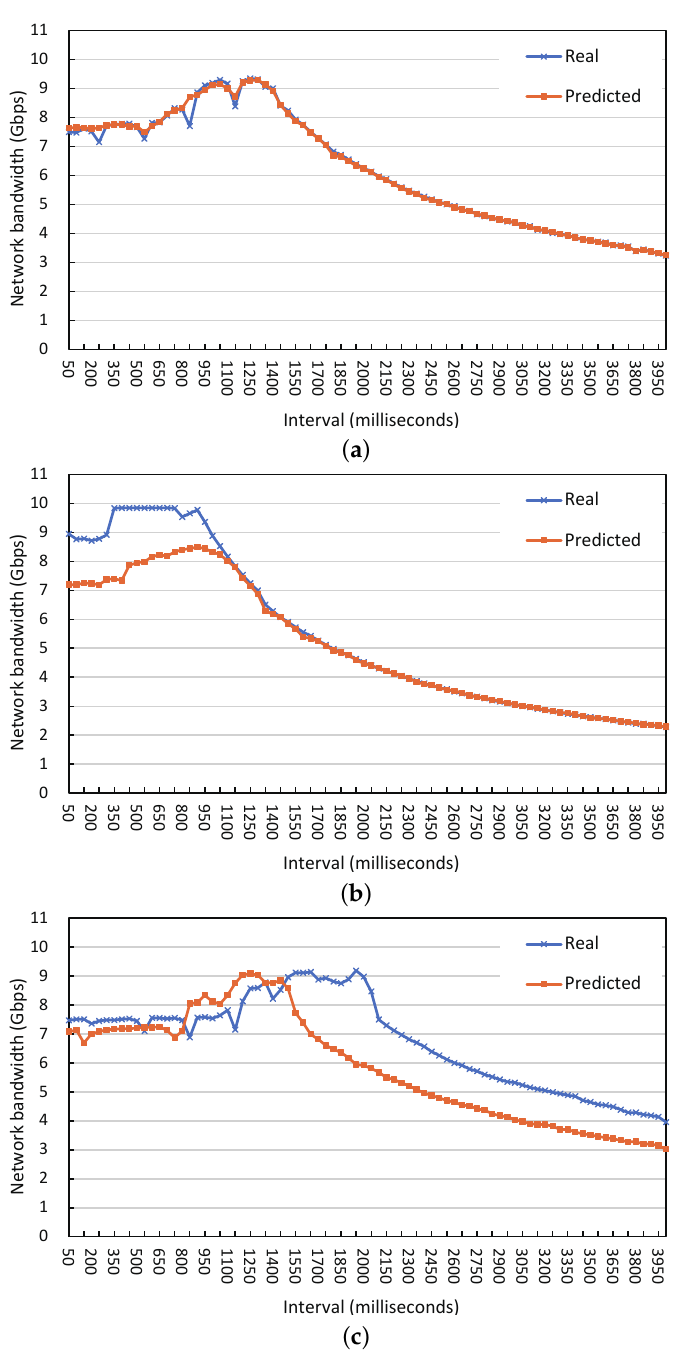
Figure 3. Experimental and predicted performance according to the polling interval. ( a ) 3 VMs, 2 threads, and 128 B message size. ( b ) 2 VMs, 5 threads, and 96 B message size. ( c ) 4 VMs, 1 thread, and 192 B message